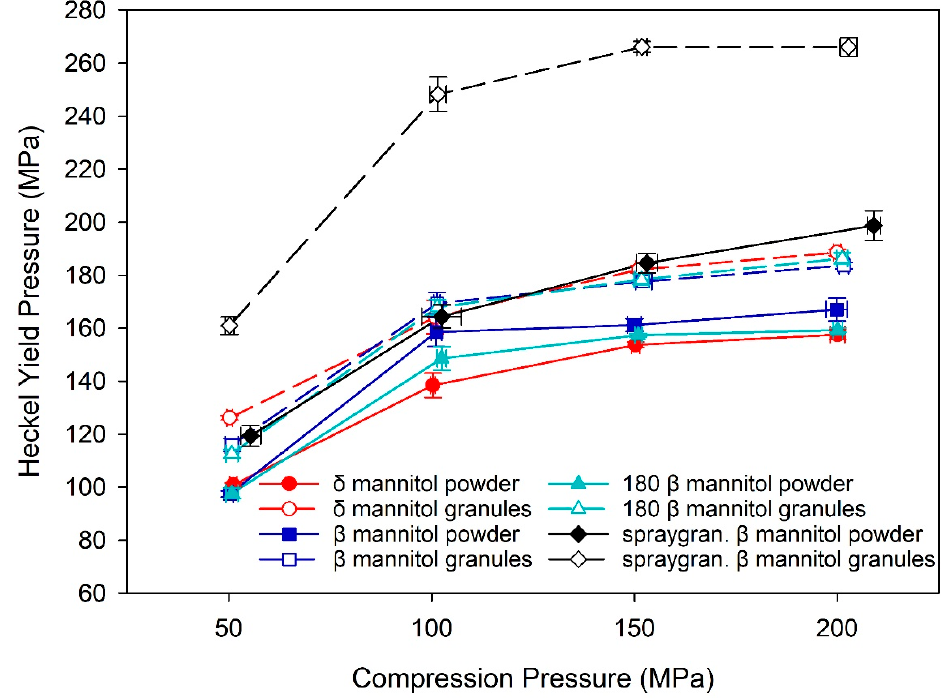
Figure 8. Heckel yield pressure of δ and β mannitol, β mannitol sieved through 180 µm sieve, and